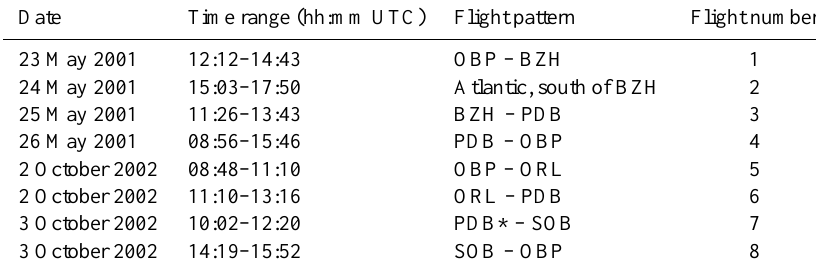
Table 2. Flight information for the CAATER 1 and CAATER 2 campaigns.